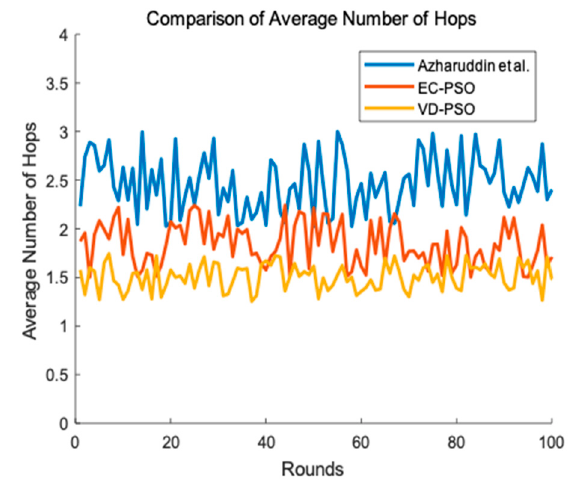
Figure 12. Average number of hops between different algorithm.